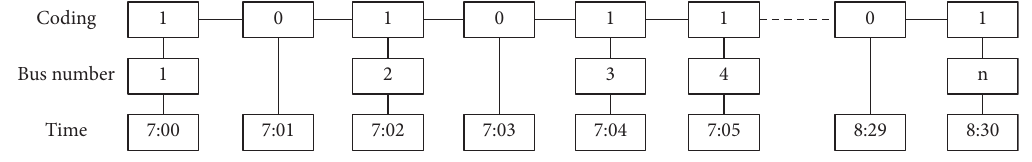
Figure 2: Structure of chromosome.